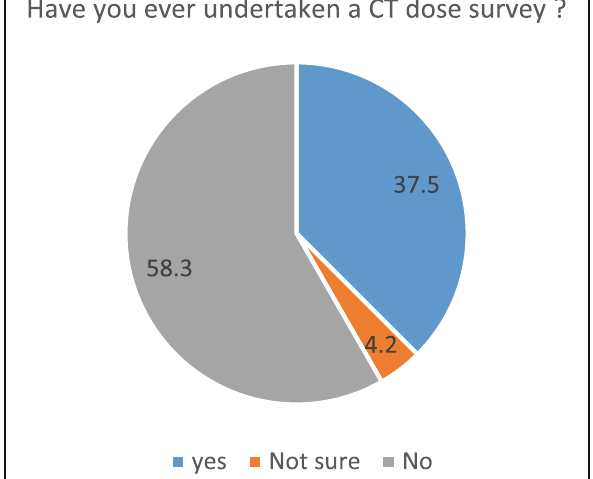
Fig. 6 Description of participants ’ who undertook a CT dose